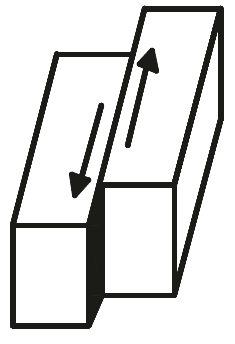
Figure 3: Strike-slip